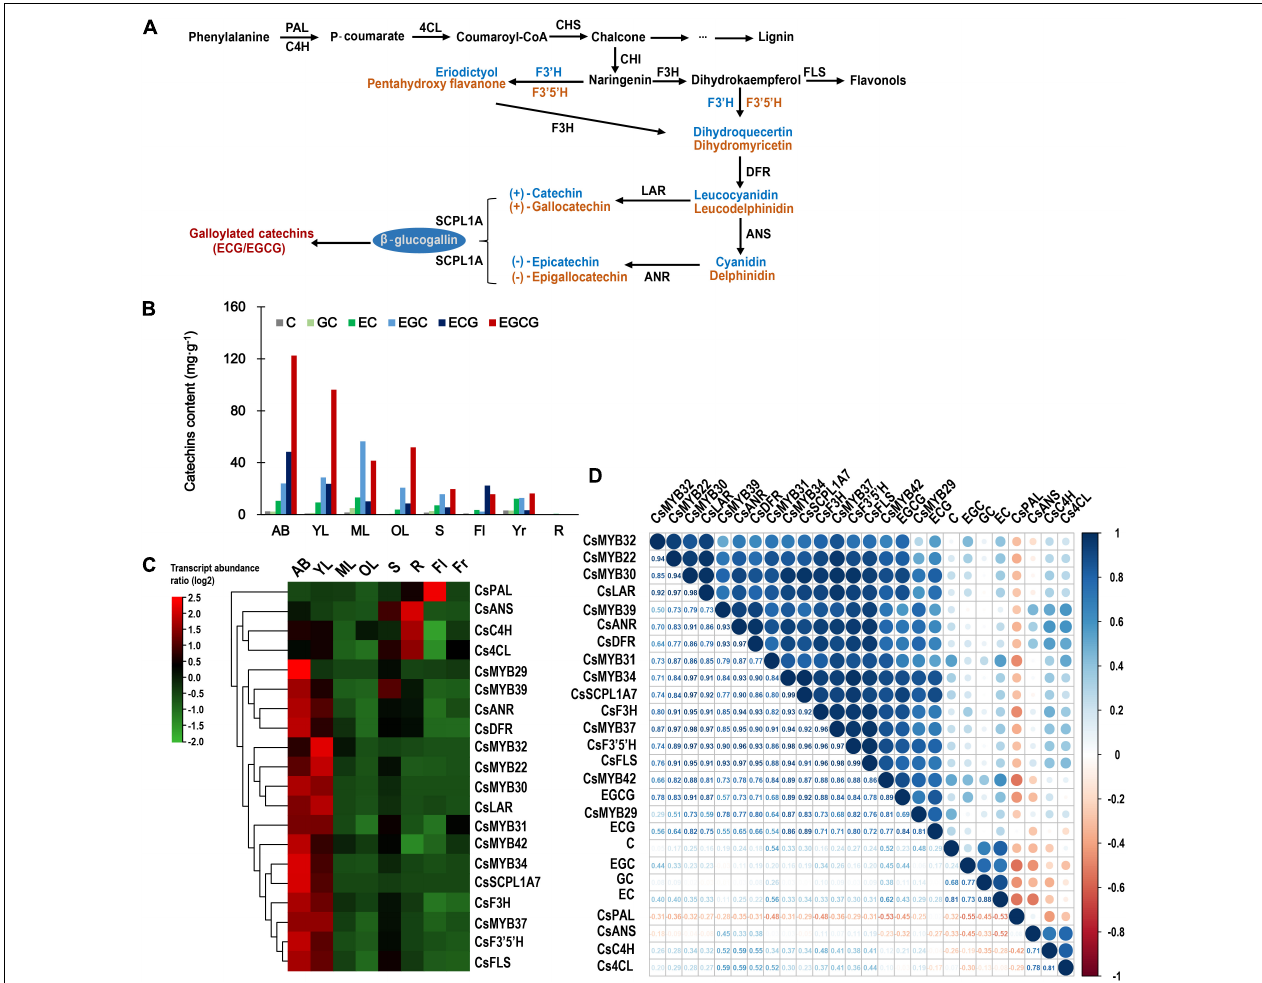
FIGURE 3 | Expression pattern analysis and correlation analysis of tea-specific or tea-expanded CsR2R3-MYB s. (A) The biosynthetic pathway of catechins. CHS , CHI , F3H , F3 (cid:48) H , F3 (cid:48) 5 (cid:48) H , DFR , ANS , LAR , ANR , and SCPL1A represent genes encoding chalcone synthase, chalcone isomerase, flavanone 3-hydroxylase, flavonoid 3 (cid:48) -hydroxylase, flavonoid 3 (cid:48) ,5 (cid:48) -hydroxylase, dihydroflavonol 4-reductase, anthocyanidin synthase, leucoanthocyanidin reductase, anthocyanidin reductase, and type 1A serine carboxypeptidase-like acyltransferases, respectively. (B) The contents of six catechin monomers in eight tissues. (C) Heatmap of RNA-seq transcript abundance patterns of the 20 CsR2R3-MYB genes from the C. sinensis genome in eight different tissues. AB, apical bud; YL, young leaf; ML, mature leaf; OL, old leaf; S, stem; R, root; Fl, flower; Fr, fruit. (D) Correlative analysis of CsR2R3-MYB genes, structural genes, and catechins accumulation patterns in eight representative tissues of C. sinensis plants. R > 0.5 indicates a positive correlation; R < –0.5 indicates a negative correlation. Data were obtained from the Tea Plant Information Archive